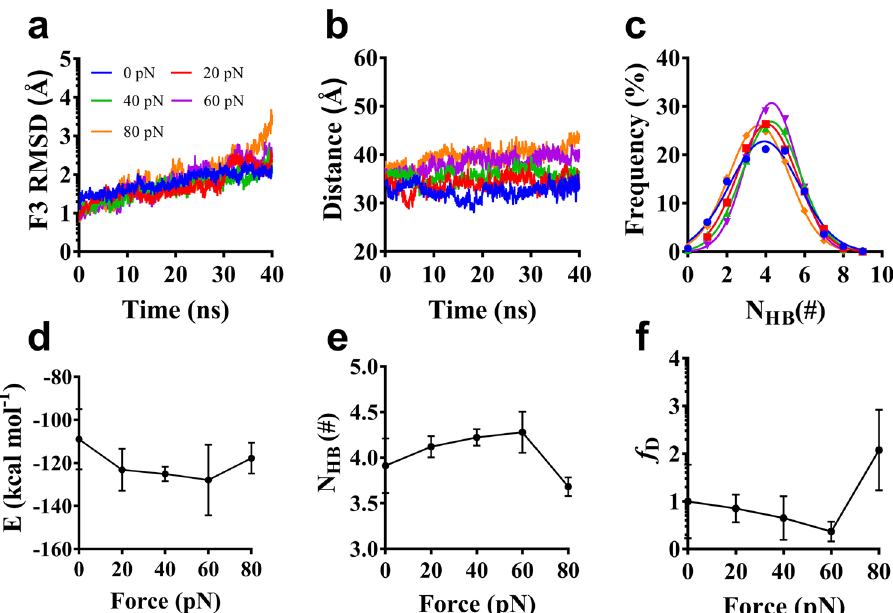
Figure 6. Variation of structural characters and interfacial interaction of complex versus tensile force. All data were from “force-clamp” SMD simulations of 40 ns thrice under tensile forces of zero, 20, 40, 60 and 80 pN. ( a ) The typical time courses of the Cα-RMSD of the ligated Talin F3 domain at various tensile forces. The Cα-RMSD increased slightly (from 1.0 to 3.0 about) with time, possibly coming from structural relaxation of the clamped complex. ( b ) The typical time courses of the distances from the fixed atom to the pulled one loaded with various tensile forces. The mechanical stability of the complex was demonstrated by the distances at a plateau with a slight roughness of 3–5 Å about for each tensile force. ( c ) Gaussian fitting of the N HB frequencies from thrice runs of 40 ns at various tensile forces. The high R 2 values (> 0.98) for each tensile force implied that the sampled conformational spaces were quasi-perfect. Plots of the mean interaction energy E ( d ), the mean H-bond number N HB ( e ) and the mechano-regulation factor f D ( f ) against tensile force F, suggested a biphasic force-dependent interaction between Talin and β3 integrin. Pearson correlation coefficients for E, N HB , and f D were -0.36 ( p > 0.05), 0.42 ( p < 0.05), and -0.51 ( p < 0.05) if 0 ≤ F ≤ 60 pN but took 0.27 ( p > 0.05), − 0.77 ( p < 0.05) and 0.86 ( p < 0.01) if 60 pN < F ≤ 80 pN, respectively, statistically demonstrating the force-dependences of E, N HB , and f D